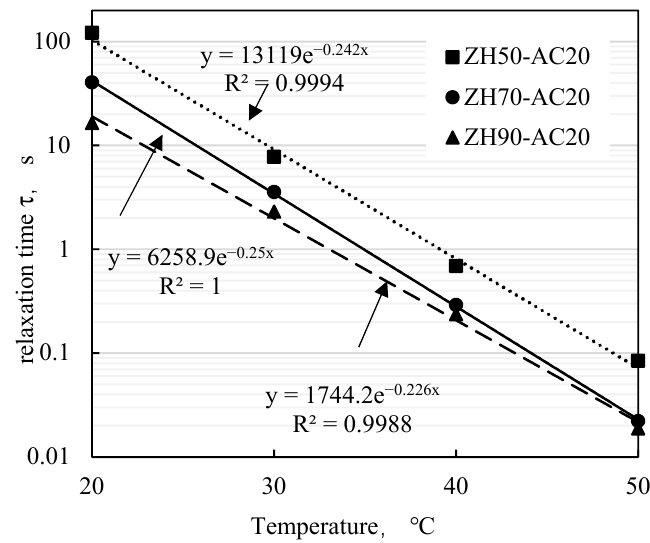
Figure 10. Relationship between relaxation time ( τ ) and temperature.